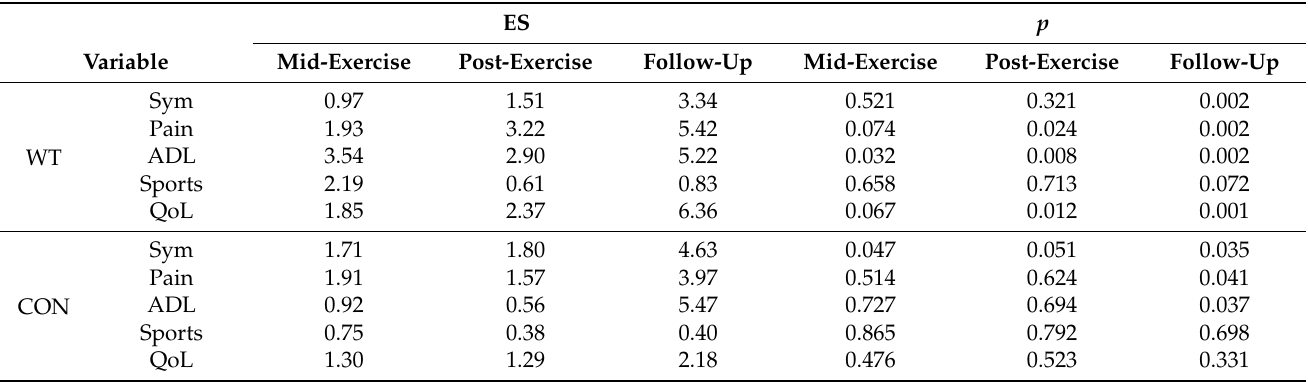
Table 7. The effect sizes and p -values of comparison of KOOS subscales between different time points and baselines within the WT and CON